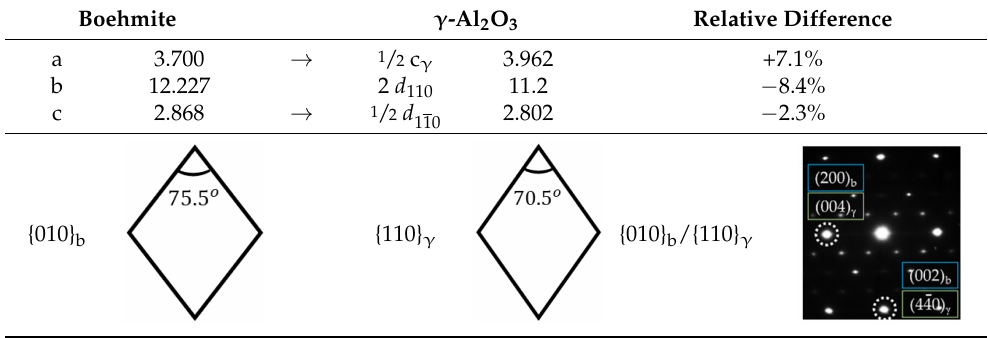
Table 1. The orientation relationships between boehmite and γ -Al 2 O 3 . Boehmite γ -Al 2 O 3 Relative